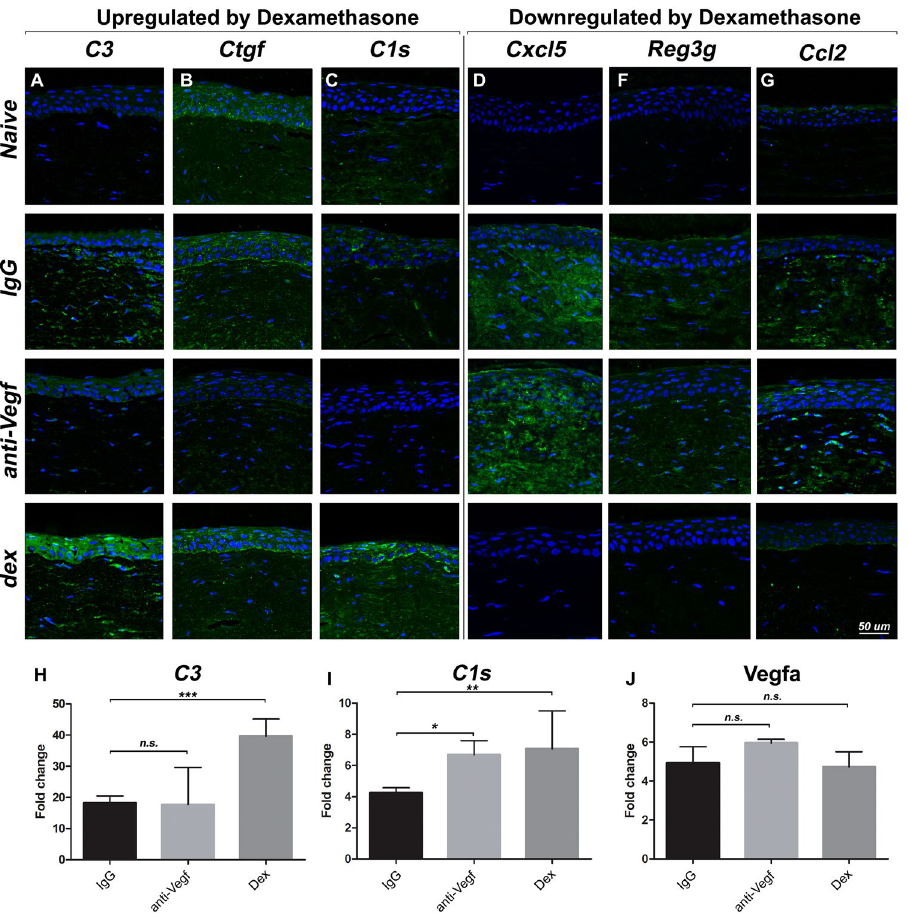
Figure 4. ( A–G ): Immunofluorescent staining of naïve, and sutured corneas from treatment groups (48 h post- suture). Factors most differentially regulated between dexamethasone and anti- Vegf groups from microarray analysis are shown. Expression signals are indicated in green, and DAPI counterstained nuclei in blue. Scale bar = 50 µ m. ( H–J ): qPCR analysis of C3 , C1s and Vegfa gene expression. The error bars represent